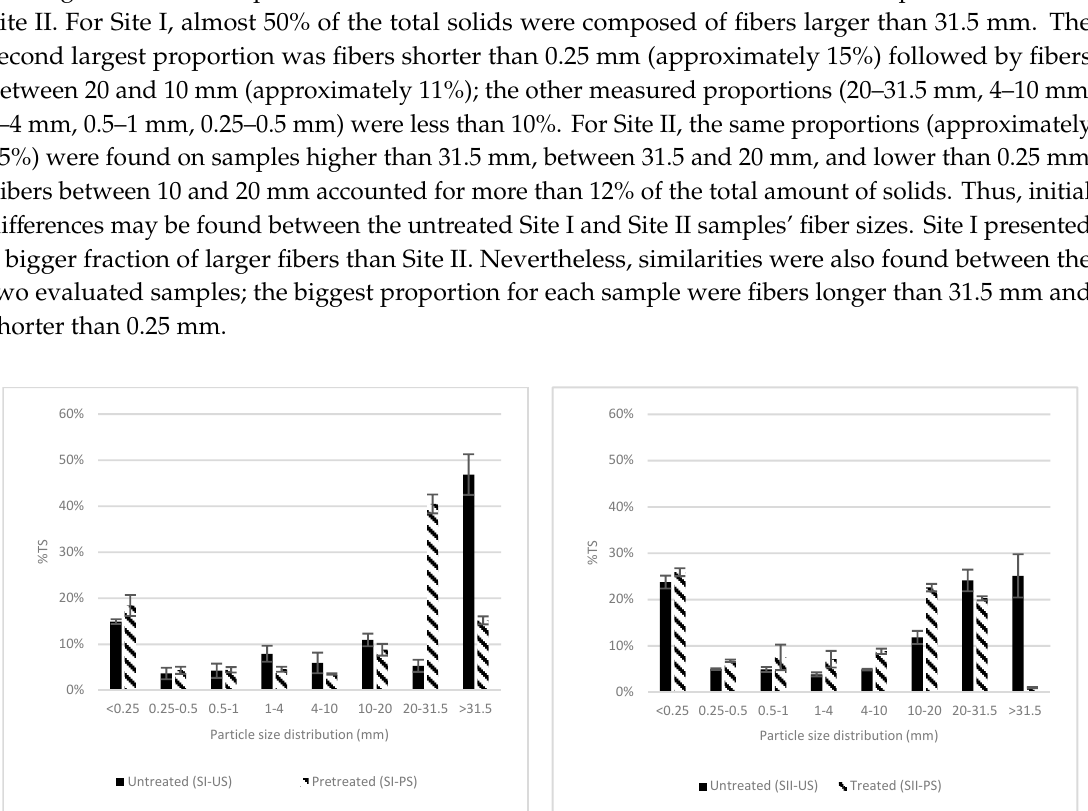
(b) Figure 3. Water retention capacity of untreated and treated samples: ( a ) Site I; ( b ) Site II. 2.3.3. Rheological Properties